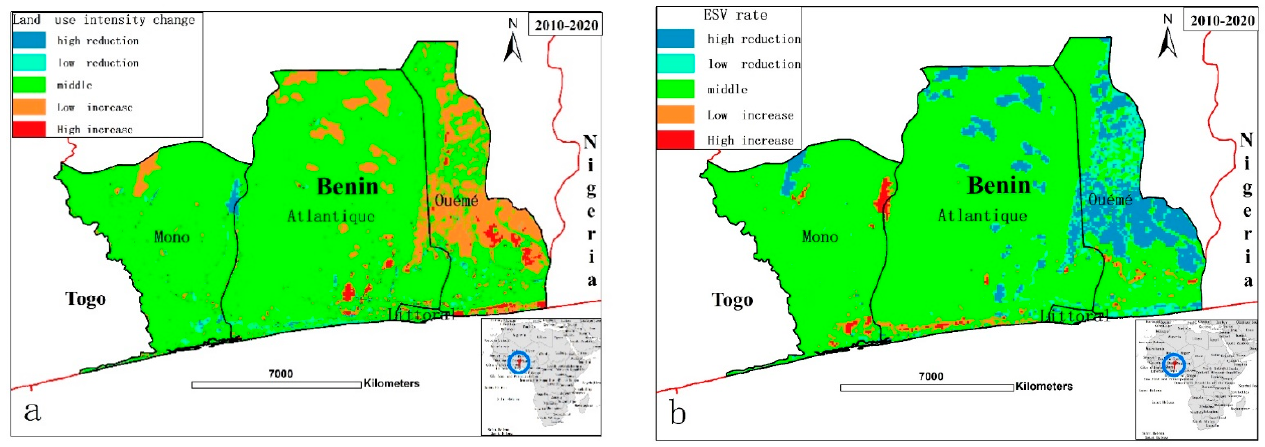
Figure 7. Consistency of land-use intensity changes with the change rate of ESV. ( a ) Map of land-use intensity 2010–2020; ( b ) Map of rate of ESV from 2010–2020.